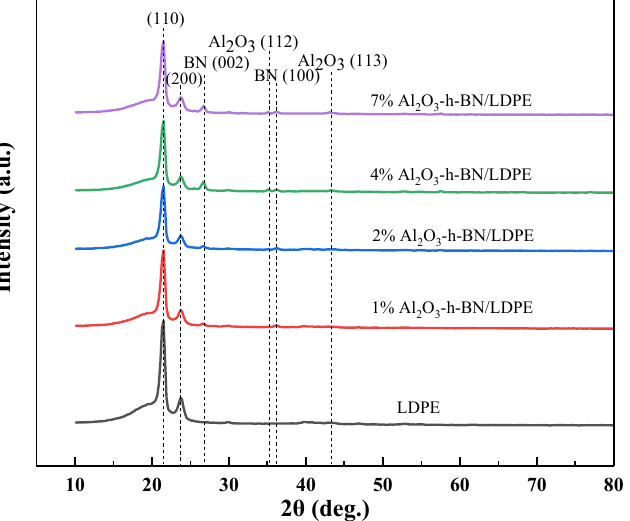
Figure 2. XRD spectra of pure LDPE and its Al 2 O 3 -h-BN/LDPE nanocomposite specimens.